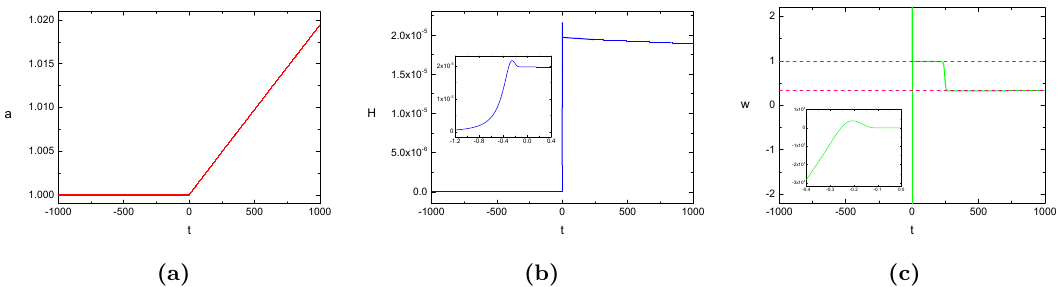
Figure 2. Evolution of the background geometry as a function of cosmic time t . The scale factor a , the Hubble parameter H , and the EoS parameter w is plotted by red, blue, and green solid line, respectively. The approximate behavior of w , i.e. w ’ 1 shortly after the genesis and w ’ 1 / 3 for the far future, is exhibited by the pink dash line.